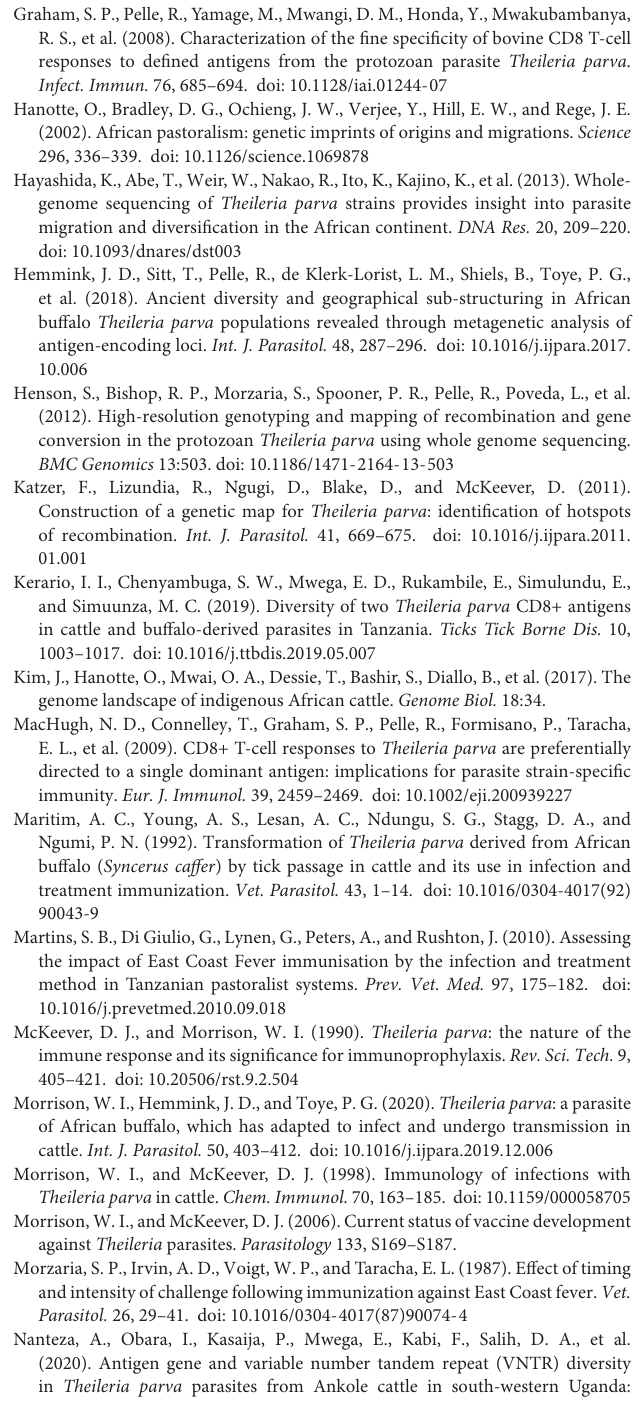
(2020). Antigen gene and variable number tandem repeat (VNTR) diversity in Theileria parva parasites from Ankole cattle in south-western Uganda: